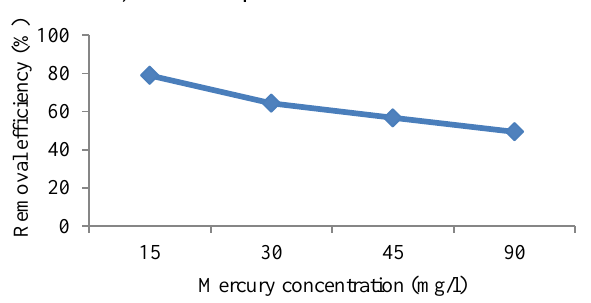
Fig. 3. Removal efficiency in various Mercury concentrations (the optimum adsorbent amount of 3 gr and balance time of 3 hours)